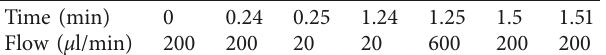
Table 1: Operating conditions with changing flow rate during the run time for the analysis (adapted from Instruction Manual for LC- MS/MS Analysis MassChrom